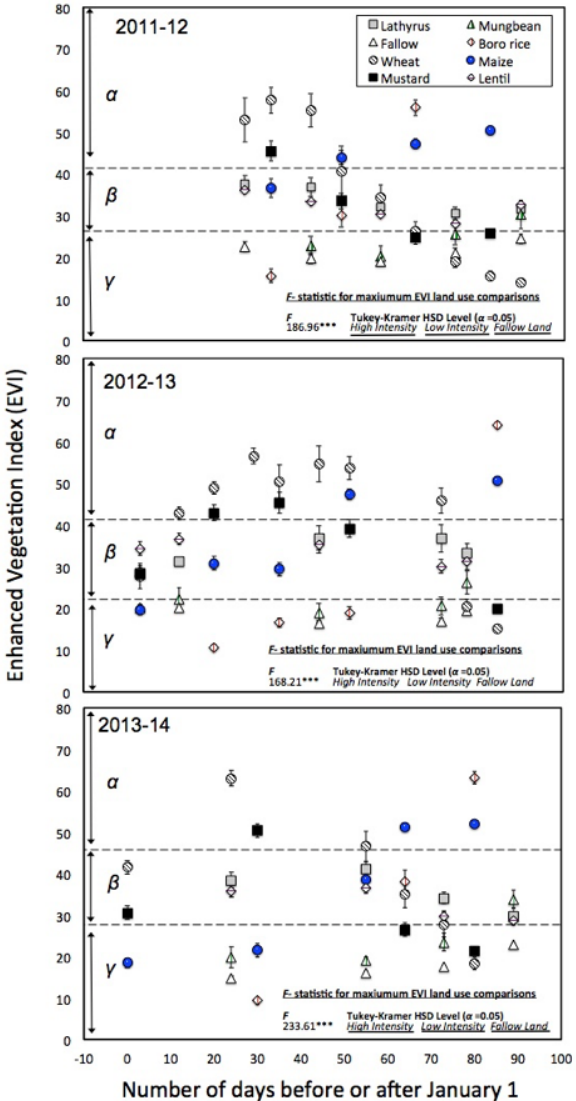
Figure 2. Dynamices of the Enhanced Vegetation Index (EVI) derived from Landsat 7 and 8 images collected over 3 winter seasons in southern Bangladesh for high- ( α ; wheat, maize, mustard, and Boro rice), low-intensity crops ( β ; lathyrus, lentil, and mungbean), and fallow land ( γ